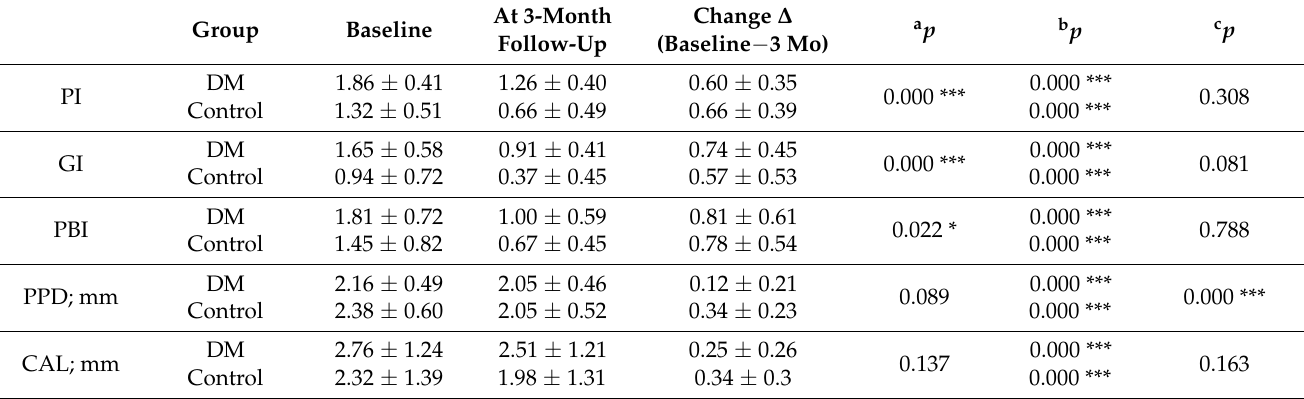
Table 2. Comparison of periodontal parameters at baseline and at three months upon periodontal therapy